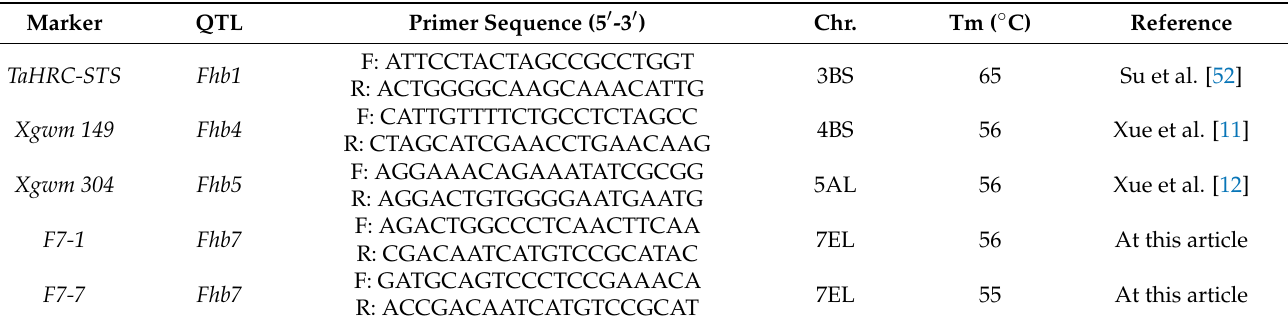
Table 2. Primers used to amplify four Fhb